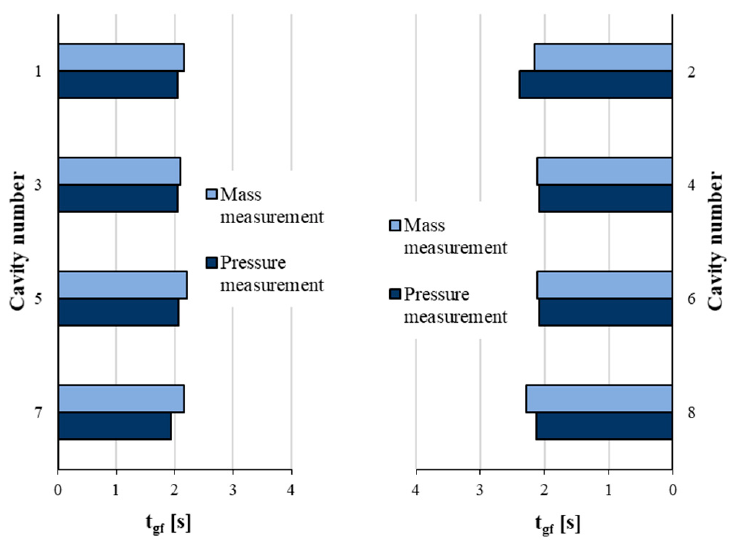
Figure 15. Predicting gate freeze-off time from the saturation curve from the measurement of mass and pressure.